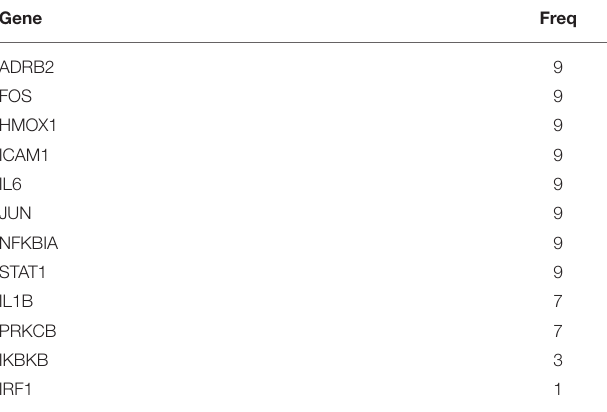
TABLE 4 | The common immune target genes of each prescription were